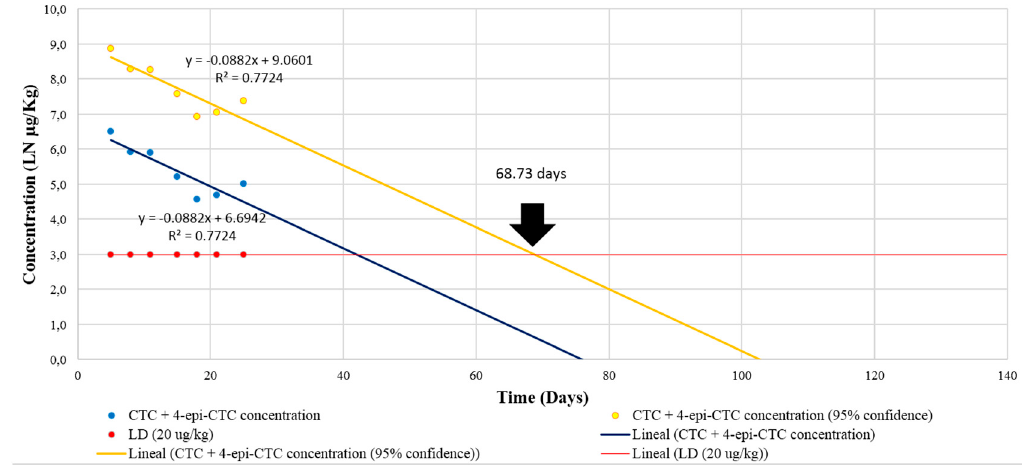
Figure 1. Depletion of CTC and 4-epi-CTC concentrations in chicken droppings (95% confidence level) showing a withdrawal time of 69 days.